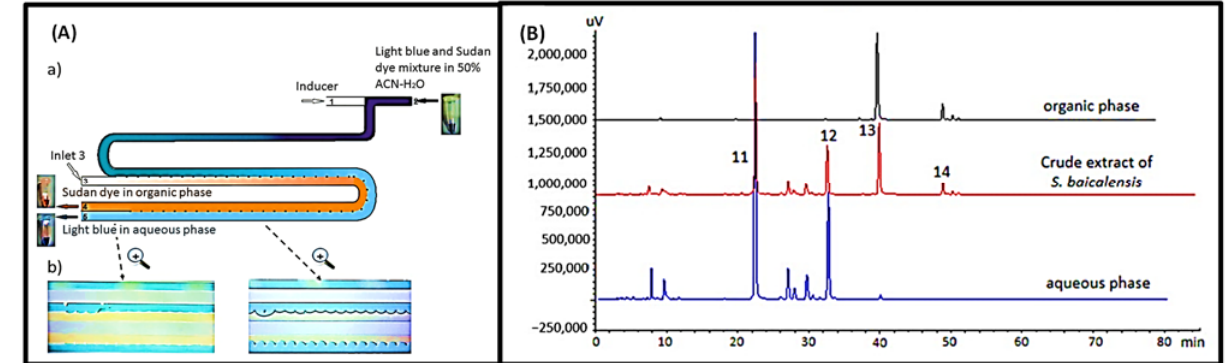
Figure 11. Schematic diagram of the isolation of Scutellaria baicalensis extract by IPSE chip to obtain aglycones and glycosides: ( A ) IPSE chip. (Aa) IPSE chip when filled with dye mixture (indigo and Sudan red); (Ab) IPSE chip when using dichloromethane-butyl acetate (2:8) to separate the dye mixture. ( B ) HPLC profiles: baicalin (peak 11), wogonoside (peak 12), baicalein (peak 13), wogonin (peak 14). The image from [10], Copyright 2021, MDPI.